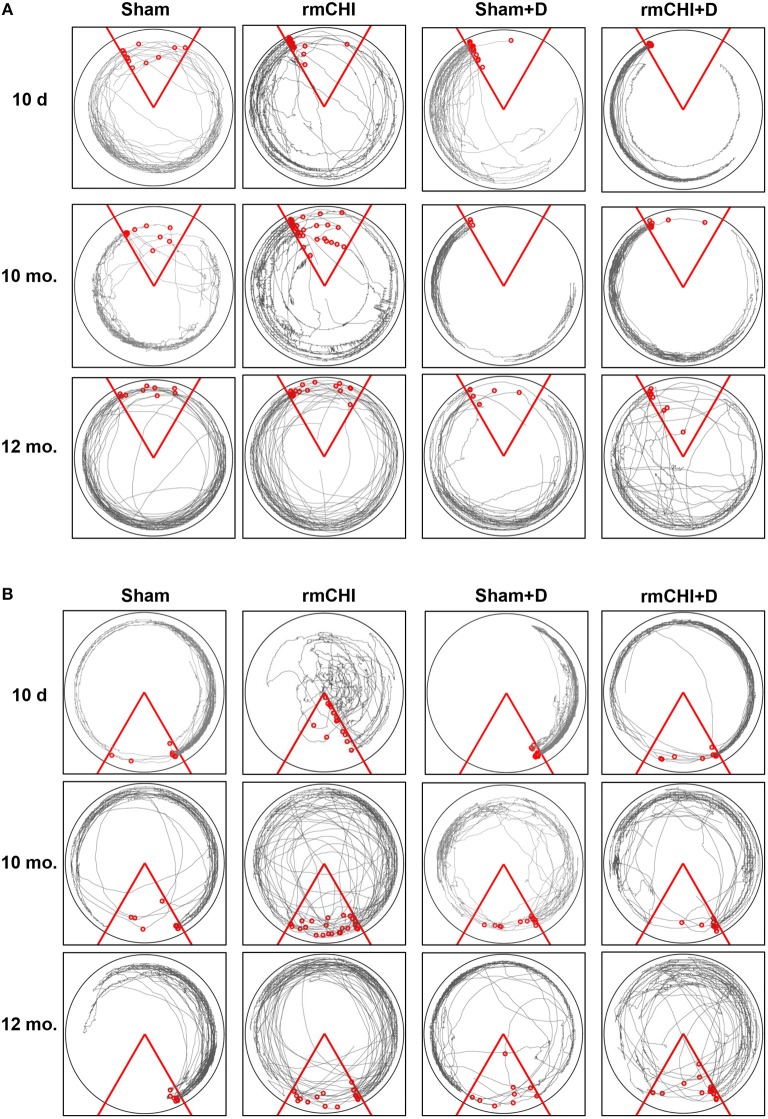
Representative tracking analysis of TghTau/PS1 mice (with and without drug treatment) post rmCHI (or sham). Movement of untreated and LiCl+ros drug-treated (D) TghTau/PS1 mice were followed and recorded for APA (A) and its position change of 180° for CAA (B) analyses protocols. Shown are representative tracking paths of individual mice during the fourth 10 min trial at the 10 day, 10, and 12 month time points post rmCHI (and sham). The testing arena is shown as a circle with the location of the triangular 60°shock zone (red lines). The continuous black lines within the arena boundary shows the actual paths taken by the mice. Within each circular arena shown, the red circles represent the location of an individual mouse from the indicated groups. The number of small red circles within each arena's triangular space represents how often the mouse entered the shock zone area and received a shock.